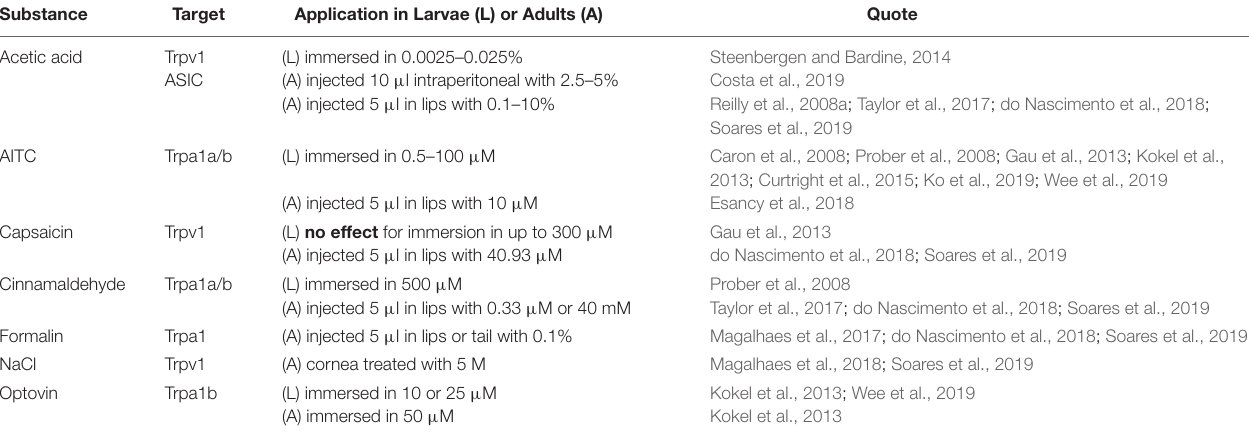
TABLE 1 | Low molecular weight substances with algogenic potential. Substance